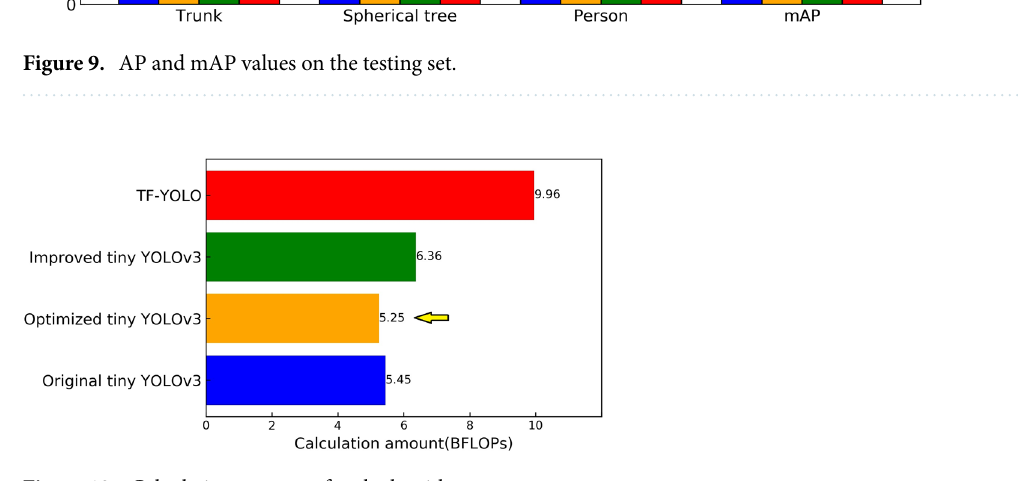
Figure 10. Calculation amount of each